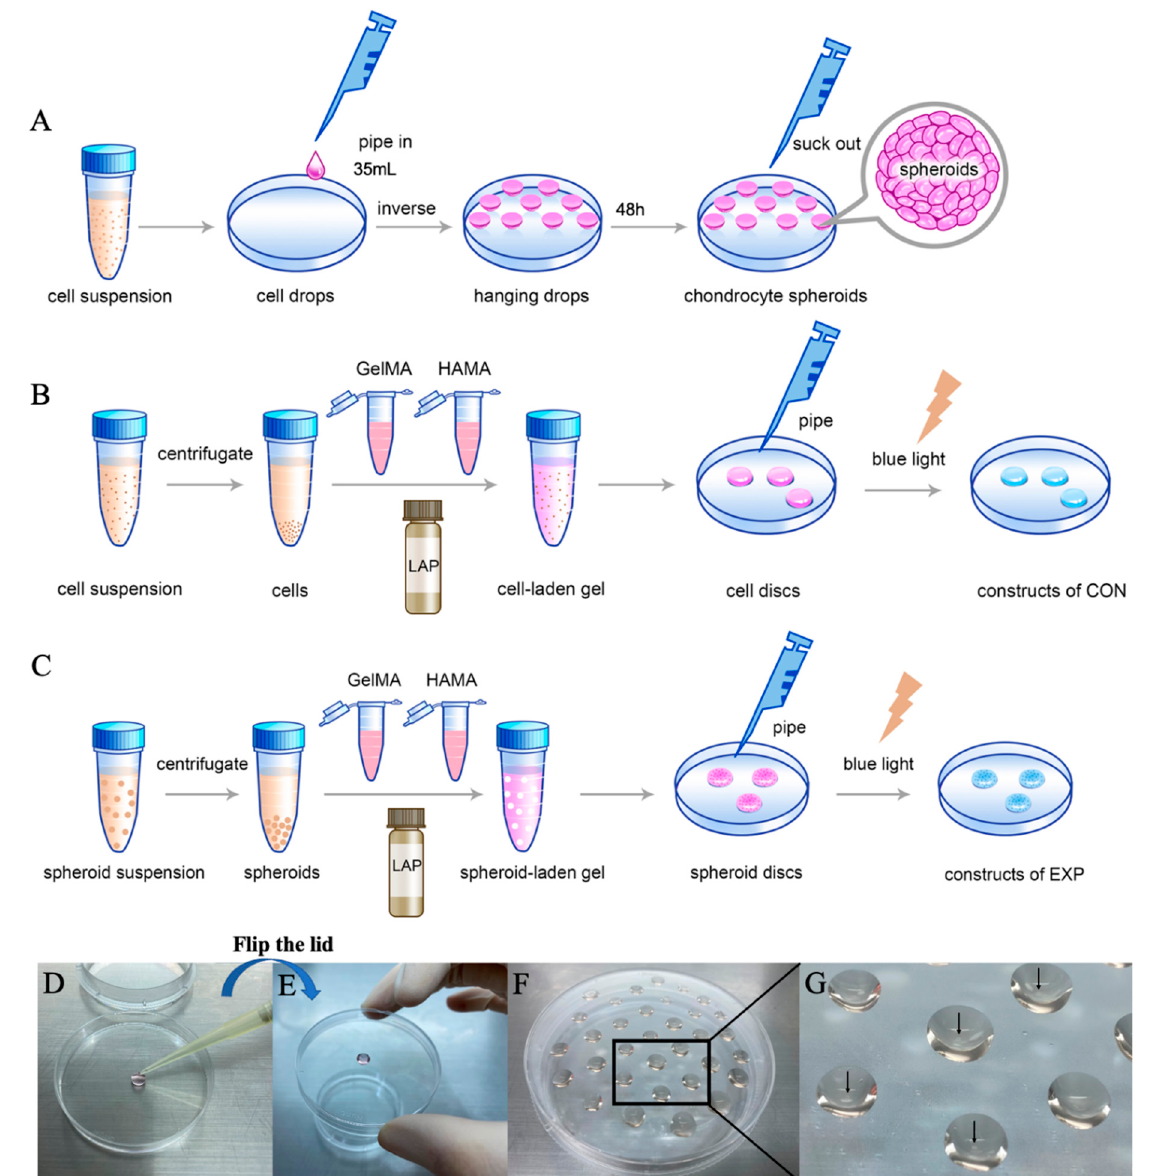
Figure 2. The schematic diagram of the production processes of chondro-spheroids ( A ), cell-laden hydrogel constructs ( B ), and spheroid-laden hydrogel constructs ( C ). During the procedure, a 200 µ L pipette gun is used to extrude a 35 µ L cell suspension on the Petri dish lid ( D ), and then the lid is quickly turned over by hand to prepare the hanging drop ( E ). Multiple hanging drops can be prepared on one lid and taken out after 48 h ( F ). It can be seen by naked eye that the chondrocyte spheroids are formed in hanging drops as shown by the black arrows ( G